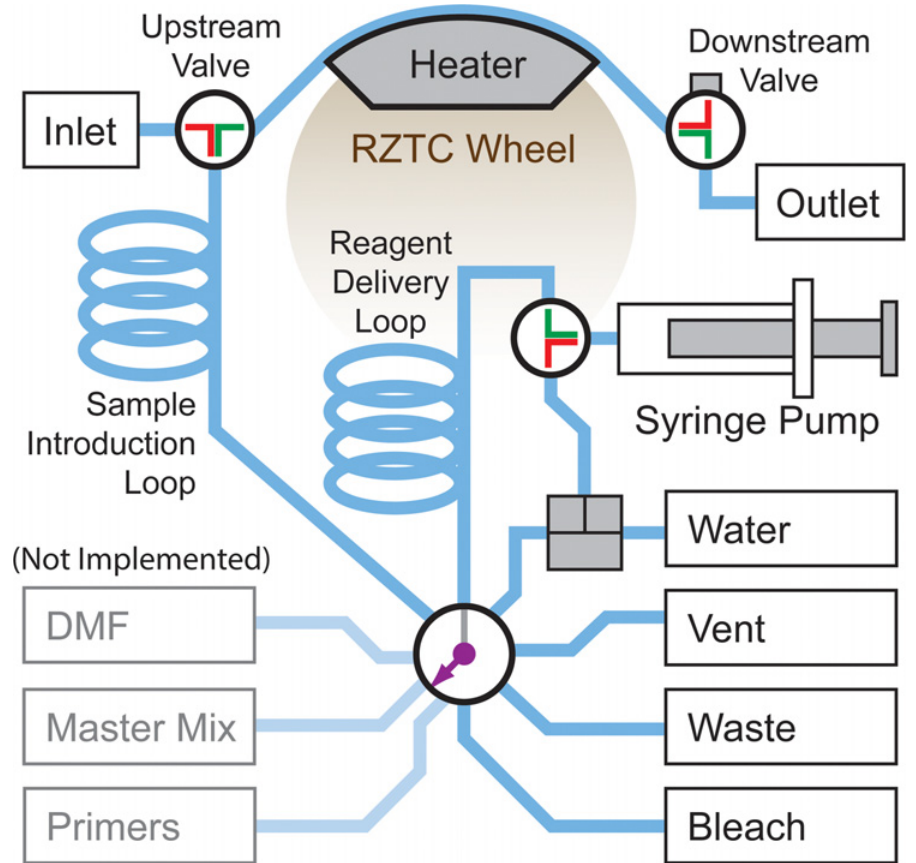
Fig 3. Functional fluidic schematic of the rzPCR system. A single automated syringe pump and multiport valve provide for sample loading, positioning, and unloading as well as between-run cleaning of the sample inlet and reactor tube. Upstream and downstream 3-way valves lock the sample in position over the center of the wheel during cycling.